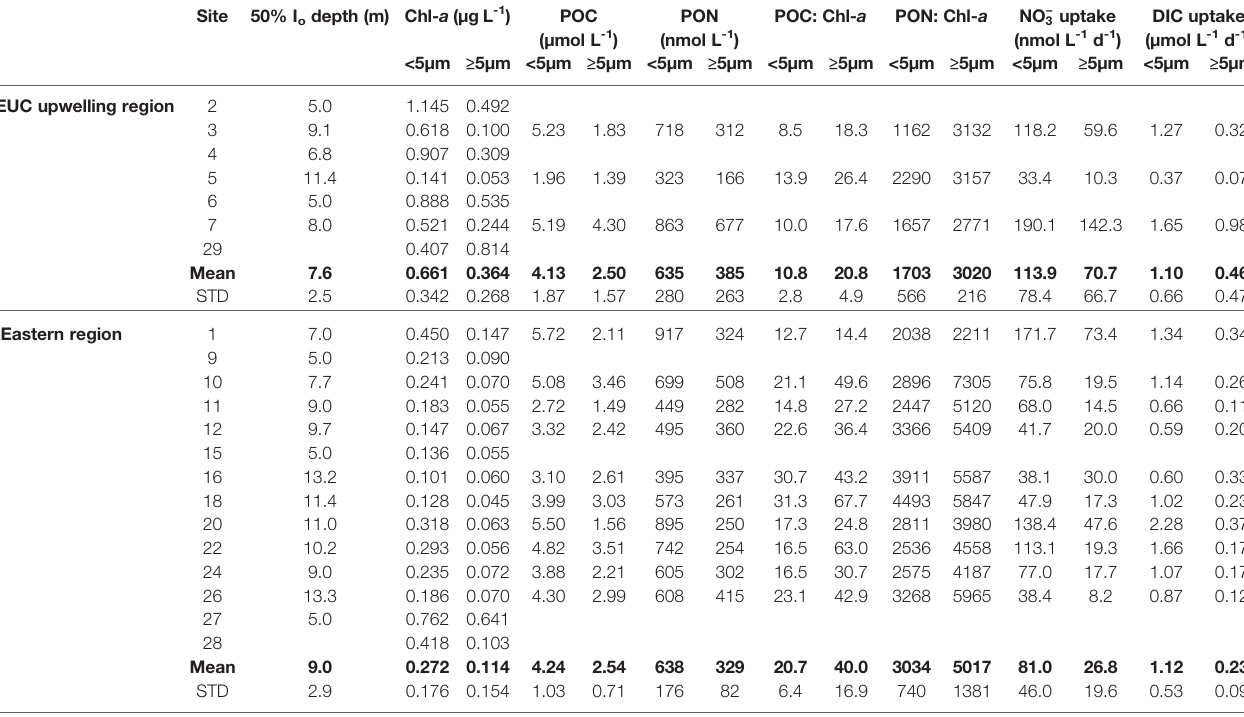
TABLE 1 | Size-fractionated Chlorophyll- a (Chl- a ), particulate organic carbon (POC), particulate organic nitrogen (PON), and nitrate NO − 3 and dissolved inorganic carbon (DIC) uptake rates in the mixed layer [50% incident irradiance (I o ) depth] at sites in Gala ́ pagos Archipelago in October 2018. Site 50% I o depth (m) Chl- a (µg L -1